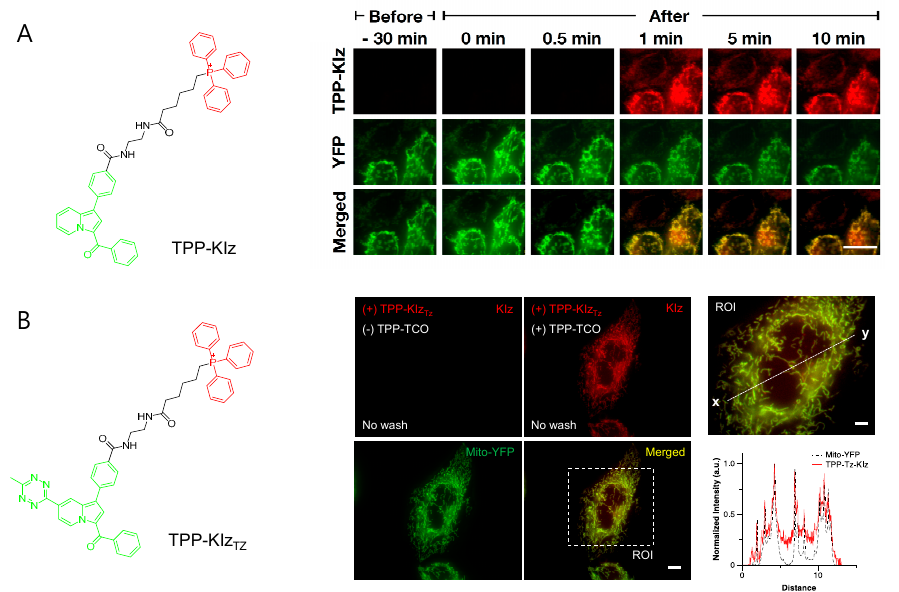
Figure 2. Washing-free mitochondrial imaging by fluorogenic indolizine mitochondria probes. ( A ) Structure of TPP-KIz and time-lapse imaging of TPP-KIz (1 nM) in Chang liver cells. Adapted with permission from ref. [29]. Copyright 2020 American Chemical Society. ( B ) Structure of TPP-KIz Tz and fluorogenic imaging of TPP-KIz Tz (100 nM) after addition of TPP-TCO (100 nM) in Chang liver cells. Green and red in structure indicate the fluorophore and mitochondrial-targeting moiety, respectively. Overexpression of Mito-YFP was compared to evaluate mitochondrial targeting efficiency in both figures. Adapted with permission from ref. [30]. Copyright 2021 Elsevieer B. V.